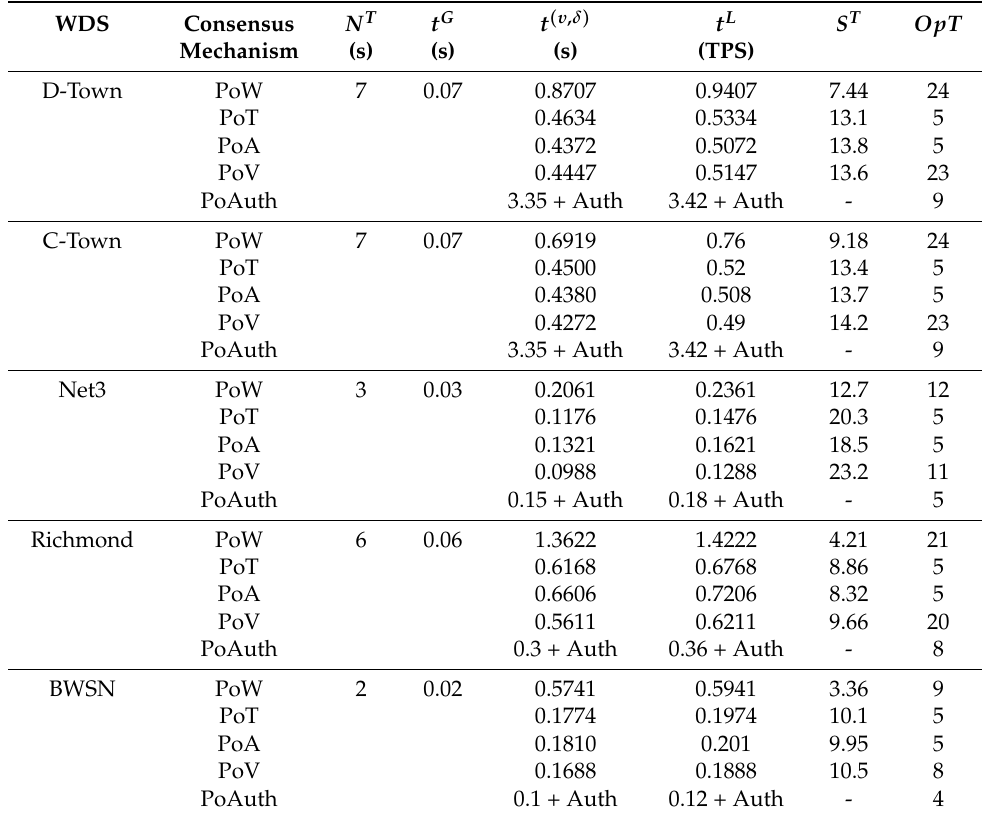
Figure 3. C-Town Distribution Model as an example of one of the case studies. Table 3. The calculated performance for static